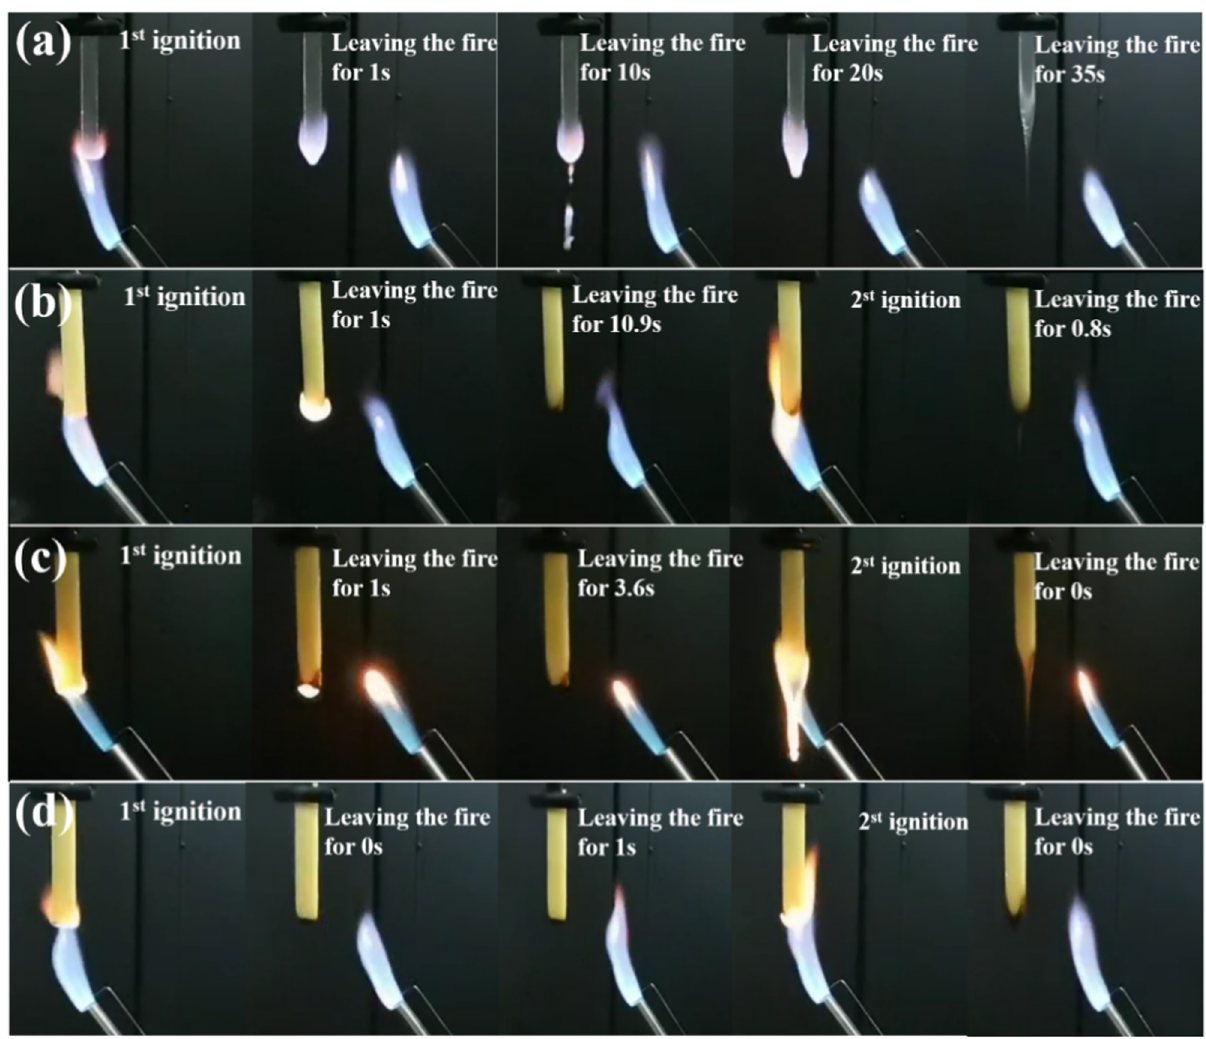
Figure 5: Results from UL - 94 measurements for PLA/HCCP - EP blends: ( a ) PLA, ( b ) PLA/HCCP - EP - 1, ( c ) PLA/HCCP - EP - 3, and ( d ) PLA/HCCP - EP -